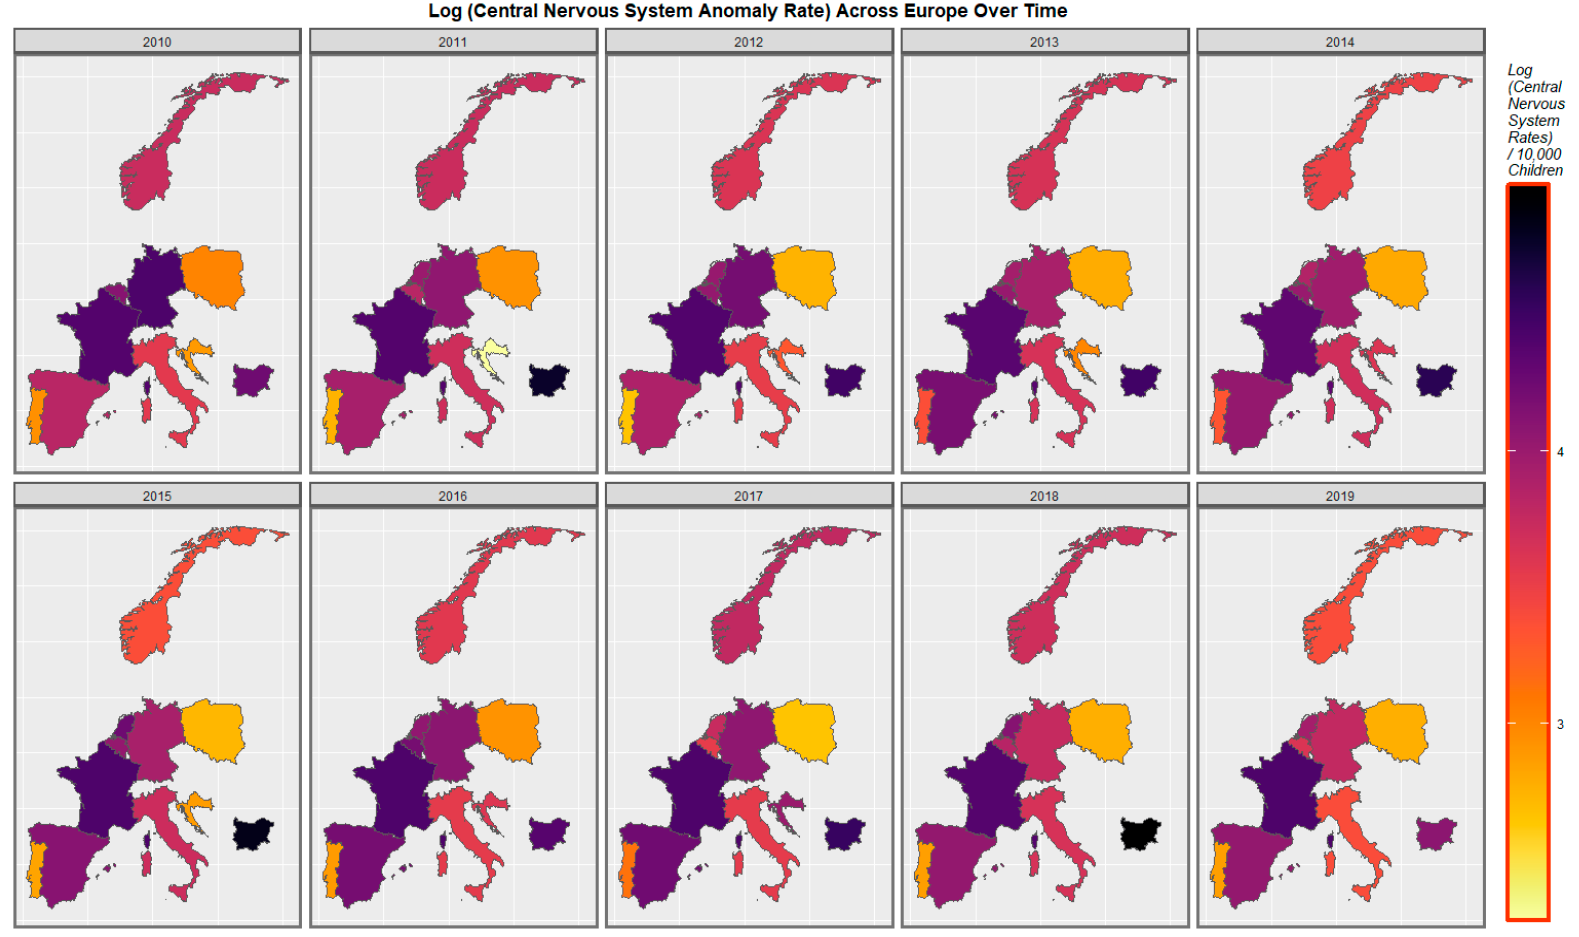
Figure 3. Sequential map-graphs of log (central nervous system anomaly rates) across surveyed European nations over time, 2010–2019.